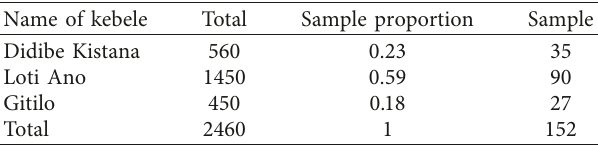
Figure 1: Conceptual framework of the study. Source: The authors’ own design. Table 2: Total number of sample household